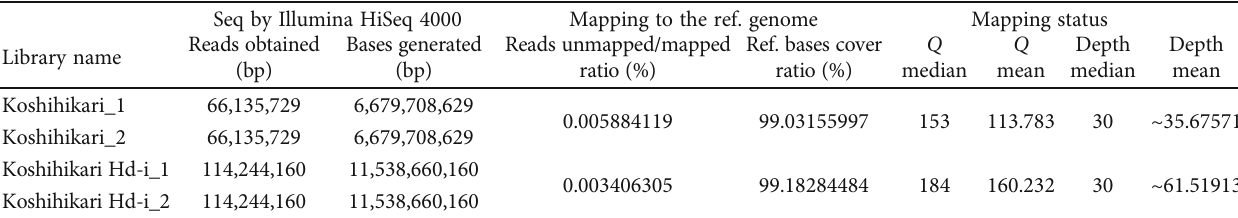
Table 1: Summary of resequencing data by next-generation sequencing. Seq by Illumina HiSeq 4000 Mapping to the ref. genome